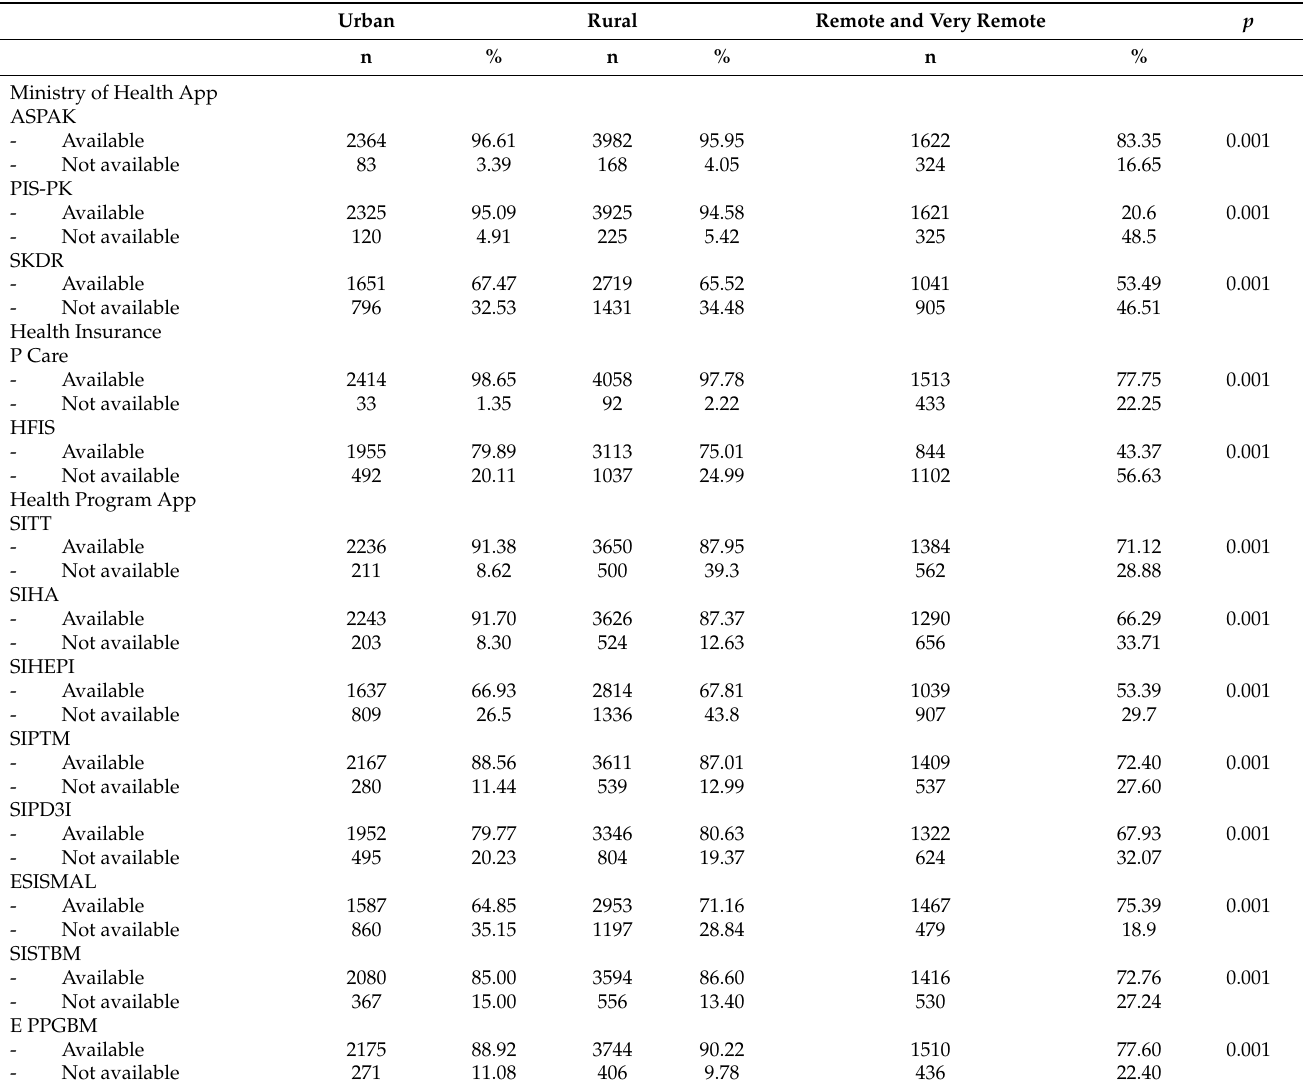
Table 2. Number of applications or programs in urban, rural, and remote